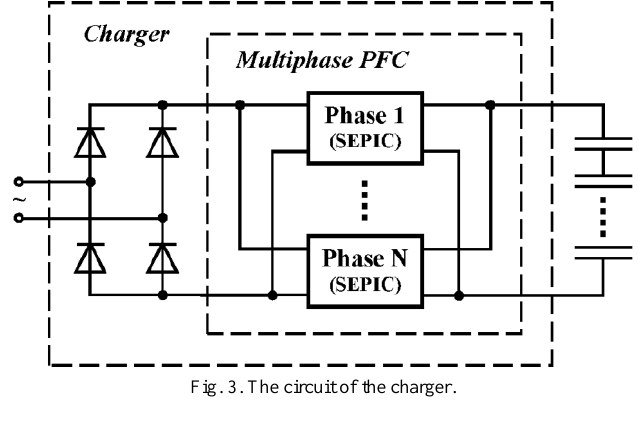
Fig. 3. The circuit of the